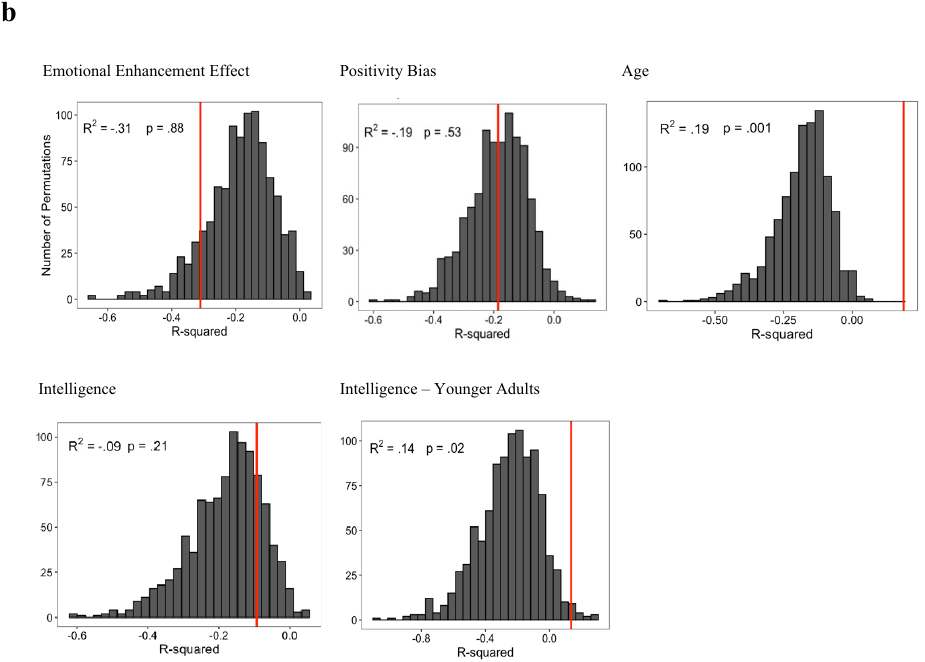
Figure 1. The prediction performance of the models for emotional enhancement effect, positivity bias, age, intelligence, and intelligence for younger adults only. ( a ) Scatter plots showing demeaned and deconfounded observed values versus those predicted by the models. Pearson’s correlation and the one tailed p value of the correlation obtained from permutation are shown on the graph. The best fitting line is displayed in blue. Slopes closer to 1 (dotted line) show good prediction 36 . ( b ) The distribution of the permutation models’ R 2 (in grey), which is the null distribution. The model’s R 2 are shown in red. The models’ R 2 and one-tailed p value obtained from permutation are displayed on the